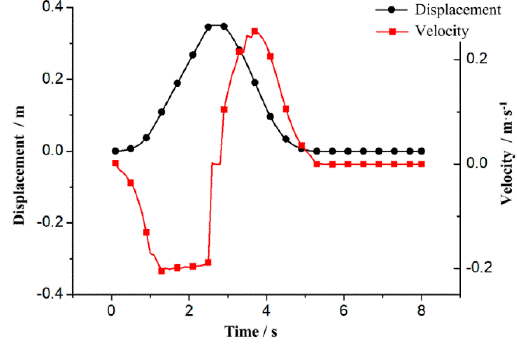
Figure 5. Curves of velocity and displacement of the arm cylinder.